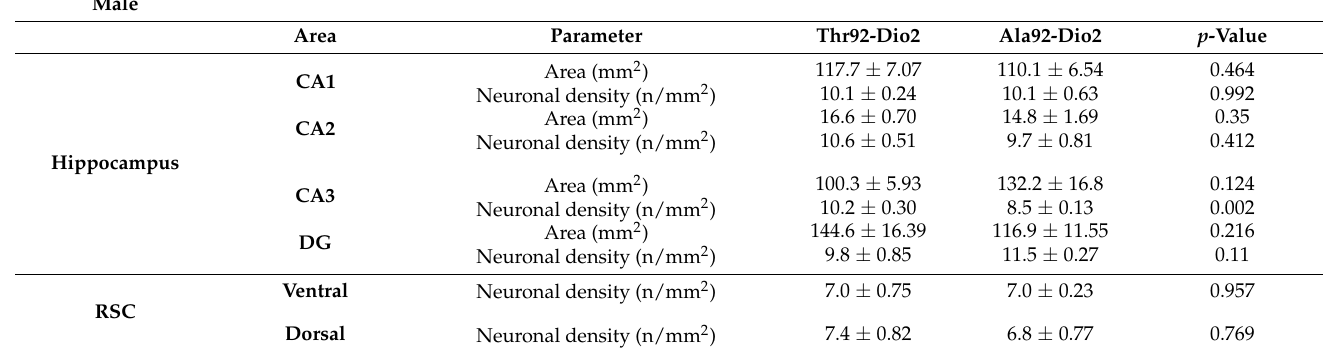
Table 3. Area and neuronal density of Cornus ammonis (CA1, CA2, CA3) and Dentate gyrus (DG) hip-